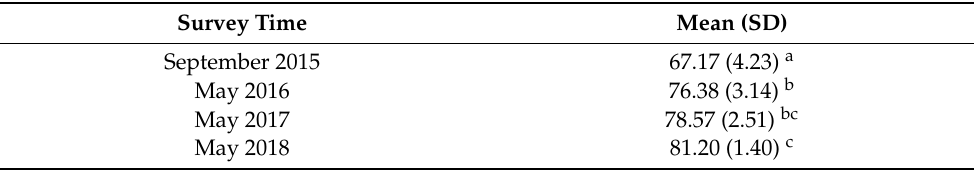
Table 2. Mean and standard deviation (SD) of mentored students (G2a).